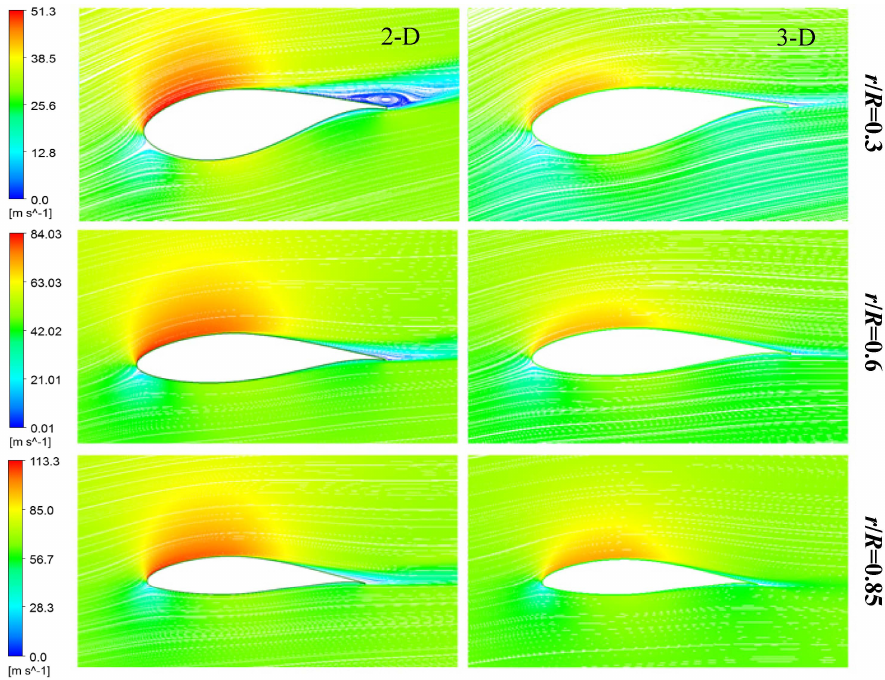
Figure 6. Streamlines around the radial